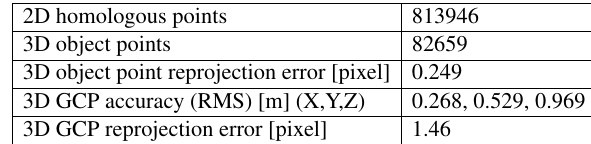
Table 3. Bundle block adjustment: 2D homologous points, 3D object points and their reprojection error, 3D ground control point (GCP) accuracy (RMS) and reprojection error.